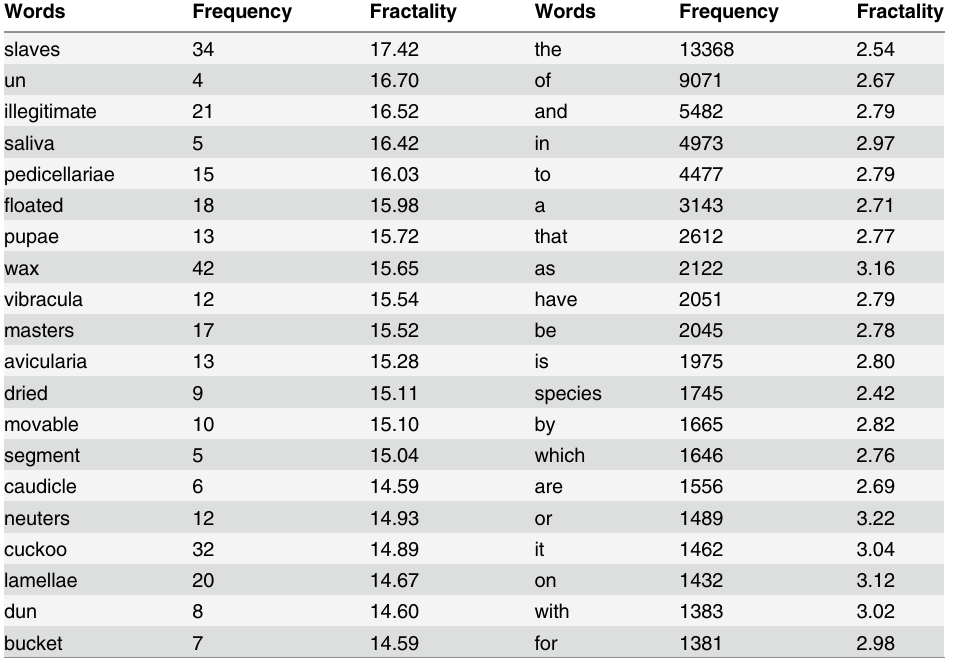
Table 1. List of the twenty top-ranked words according to degree of fractality (left) and the first twenty frequent words (right) from the book The Origin of Species . Words with high degree of fractality are important words according to subject of the book and common words have low degree of fractality. The string un which is placed in the second row of list of top-ranked words is a French determinant which appears four times in a single sentence. So, it is highly clustered and has high value of fractality. Because we do not per- form any pre-processing to eliminate foreign words, this word appears in the list.